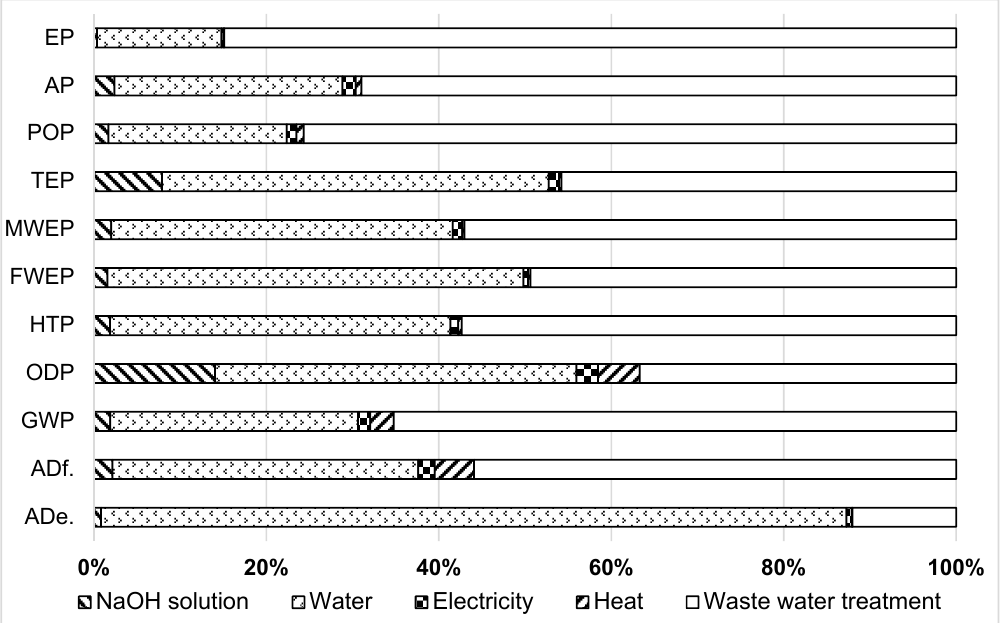
Figure 6. Percentage contribution to the impacts of the crude pomace oil refining (OPOE-A and OPOE-B).